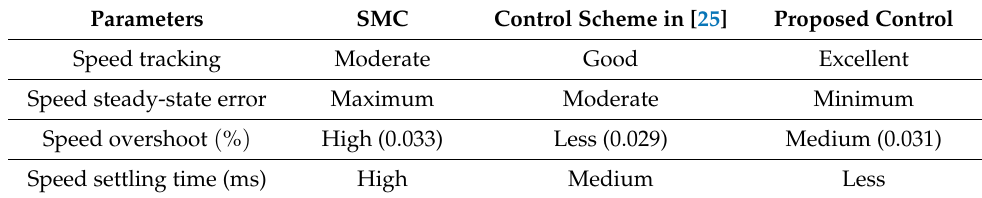
Figure 9. IPMSM drive speed response under sinusoidal speed input. ( a ) Sinusoidal speed response. ( b ) Speed error. Table 2. Comparative performance of conventional and proposed control